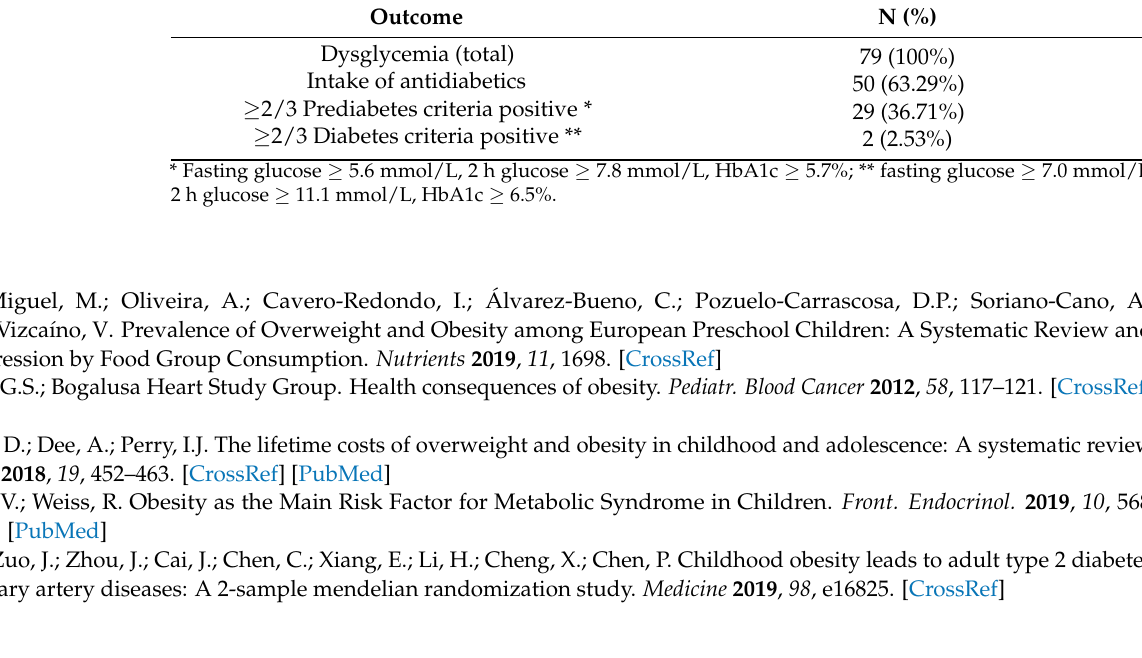
Table A1. Subgroups of dysglycemia.